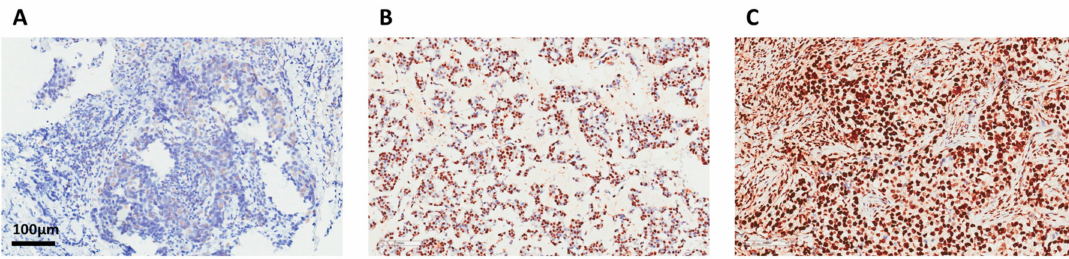
Figure 2. Immunohistochemical stain for SET. Representative images for 1+ expression in breast cancer